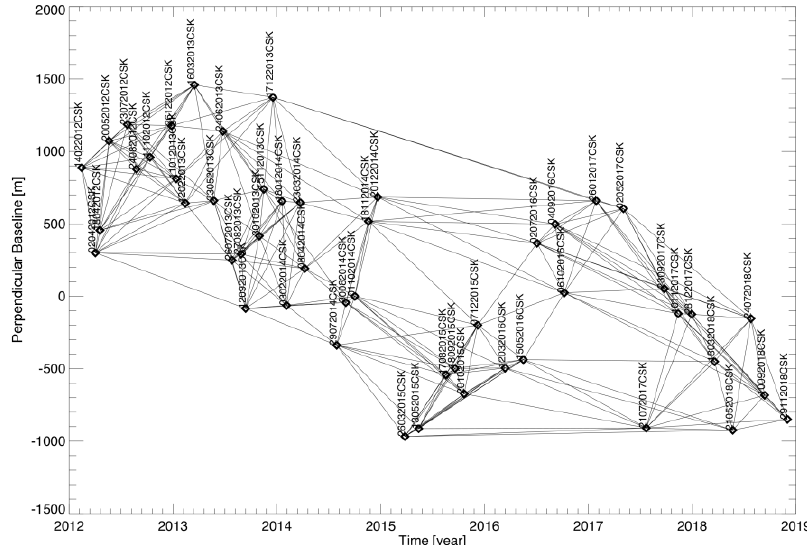
Figure 1. Distribution of the SAR data into the temporal / perpendicular baseline plane for the COSMO-SkyMed dataset of the Basilicata region, used for the experiments shown in Section 4. In particular, the dataset is composed by 50 SAR images. Starting from these data, M = 263 small baseline InSAR pairs are identified. The dates are represented in the “day-month-year” format, and the label “CSK” stands for the satellite mission.